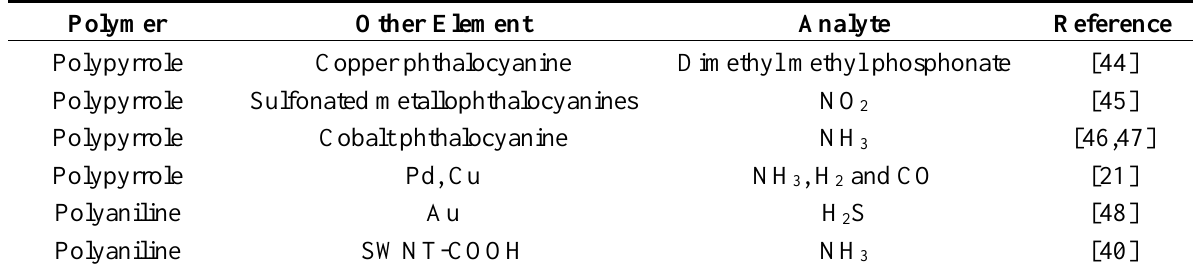
Table 2. Hybrid materials (combining an electrodeposited polymer and another element) used for gas